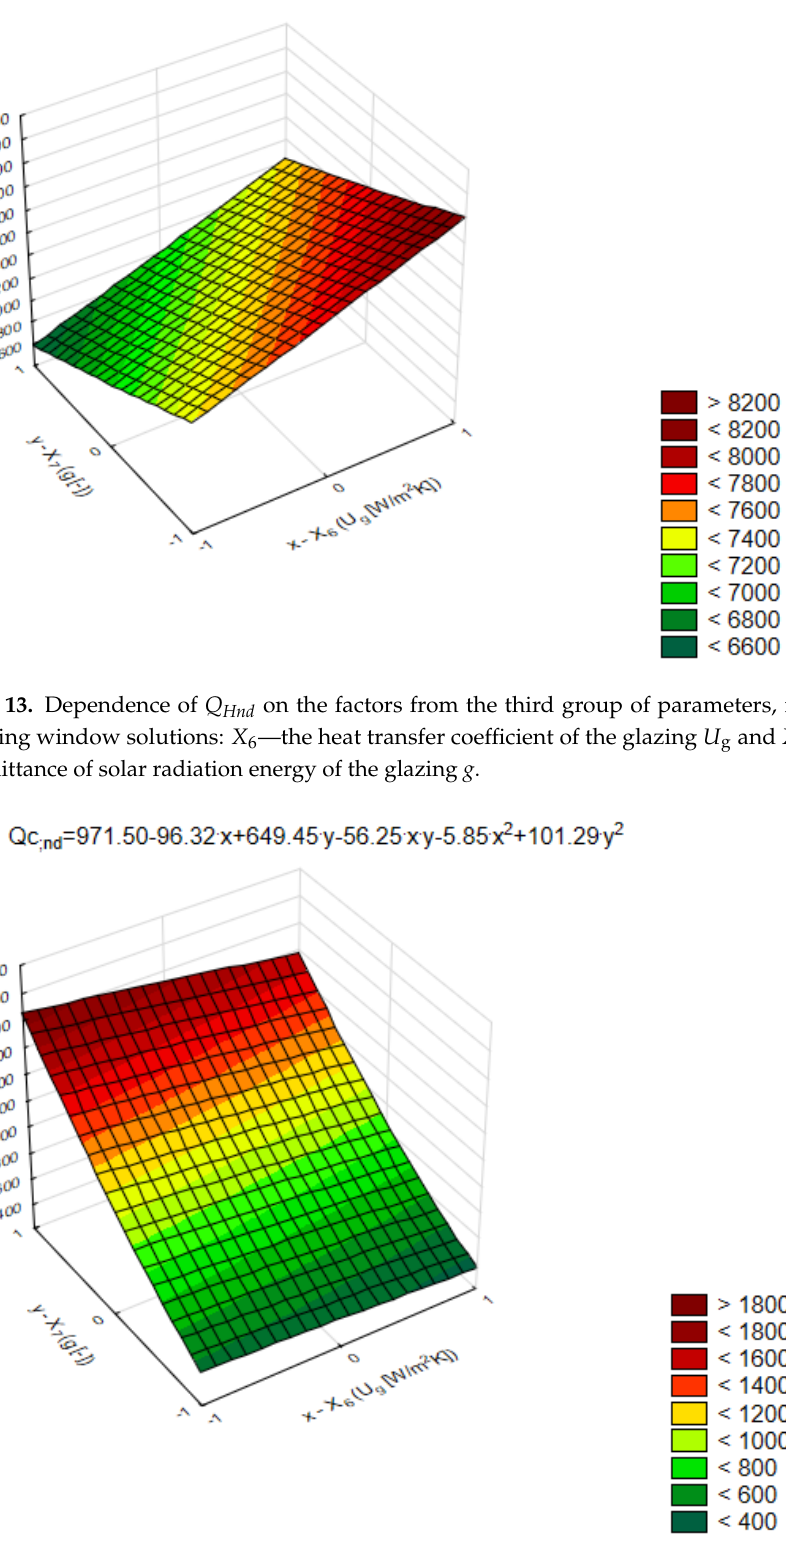
Figure 14 Figure 14. Dependence of Q Cnd on the factors from the third group of parameters, i.e., physical, regarding window solutions: X 6 —the heat transfer coefficient of the glazing U g and X 7 —the total transmittance of solar radiation energy of the glazing g